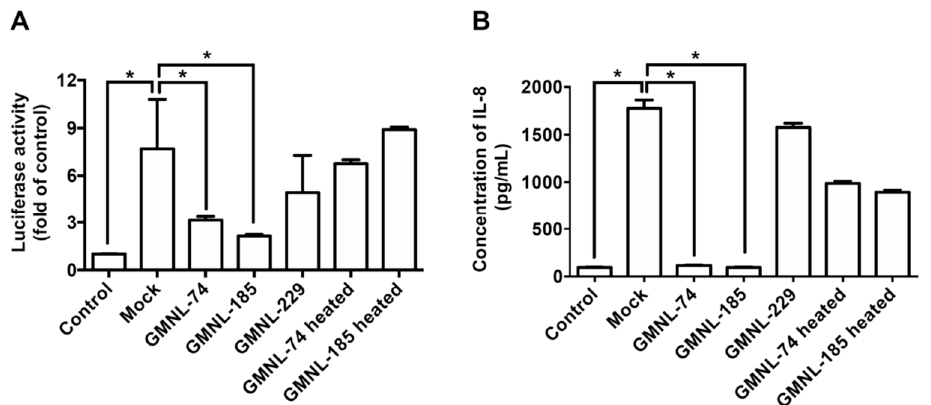
Figure 2. Inhibitory effects of Lactobacillus spp. on H. pylori -induced inflammation. AGS cells were treated with live Lactobacillus spp. (GMNL-74, 185, and 229) or heat-inactivated Lactobacillus spp. (GMNL-74 and 185) prior to infection with H. pylori 26695 at multiplicity of infection (MOI) 100 for 6 h. The levels of ( A ) nuclear factor-kappa B NF- κ B luciferase activity and ( B ) interleukin 8